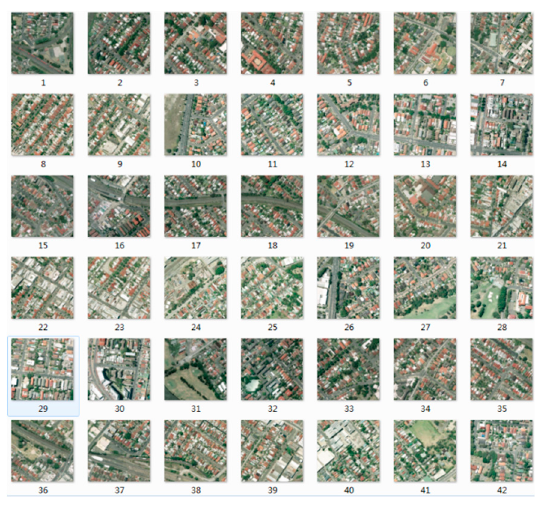
Figure 5. Parts of images of Sydney Dataset.